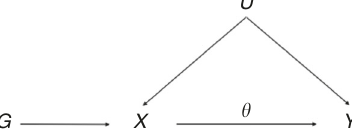
Fig. 1 Directed acyclic graph of instrumental variable assumptions made in univariable Mendelian randomization. G = genetic variant(s), X = risk factor, Y = outcome, U = confounders, θ = causal effect of interest.